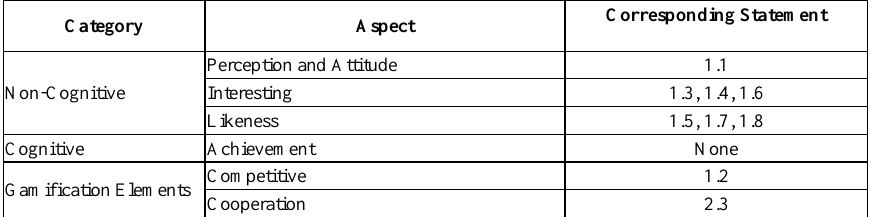
Table 4. Learning outcome aspects observed through the